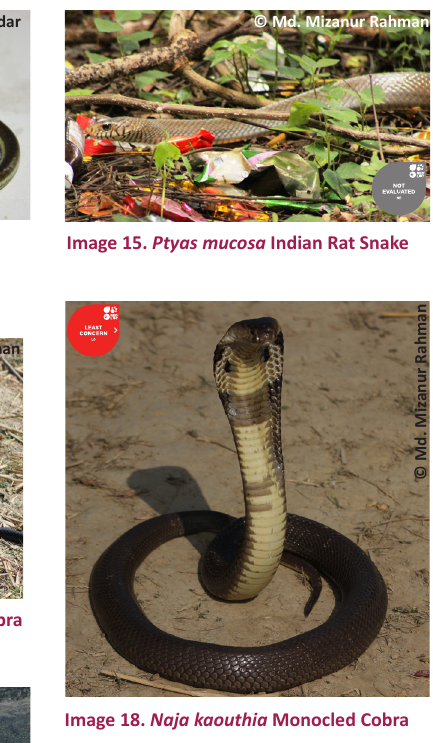
Image 16. Boiga cyanea Green Cat Snake